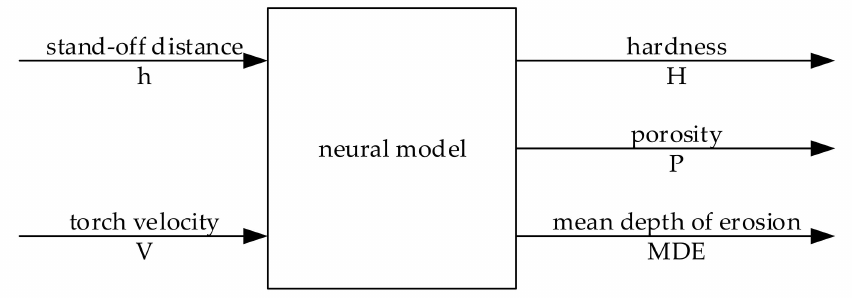
Figure 1. Block diagram of the analyzed neural